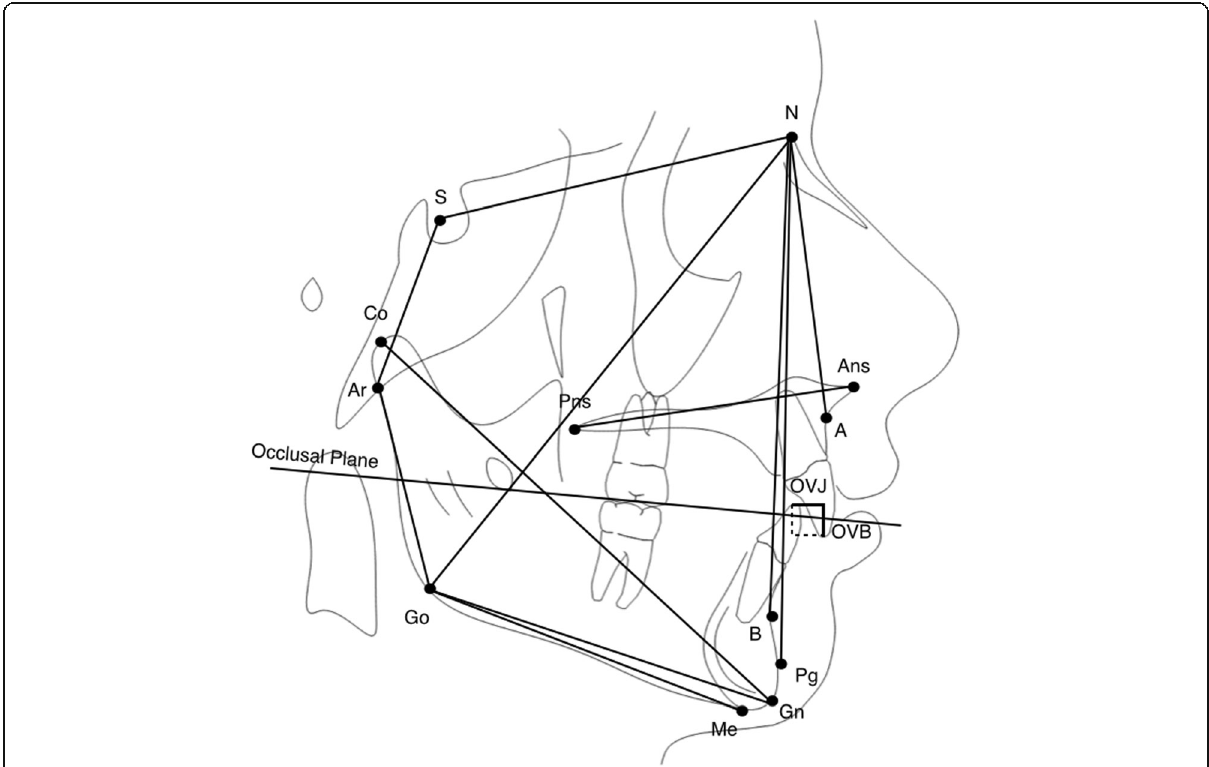
Fig. 2 Cephalometric analysis. Description of the measurements in Table